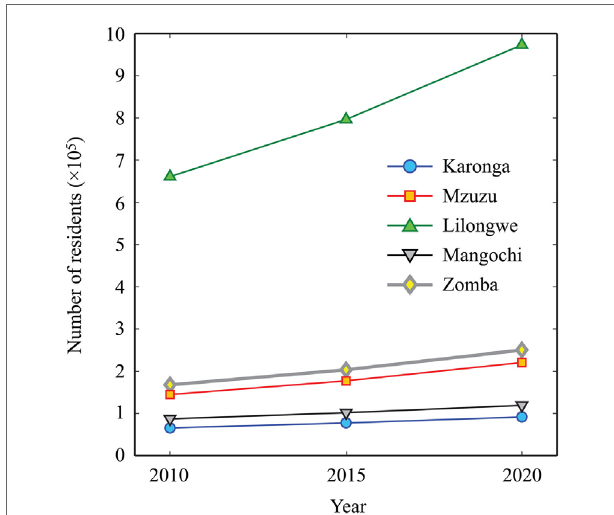
FigUre 3 | Population growth for Karonga, Mzuzu, lilongwe, Mangochi, and Zomba